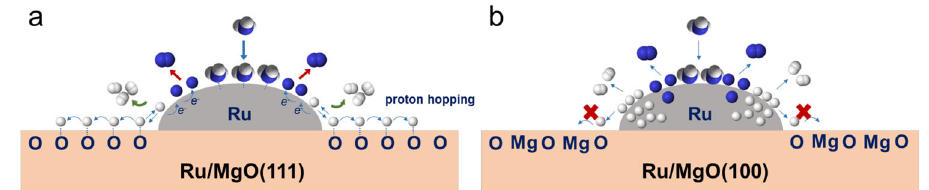
Fig. 3 | Mechanismillustration ofammonia decomposition onRu/MgO(111) and Ru/MgO(100). The different behaviors of hydrogen hopping in ( a ) Ru/MgO(111) and ( b )